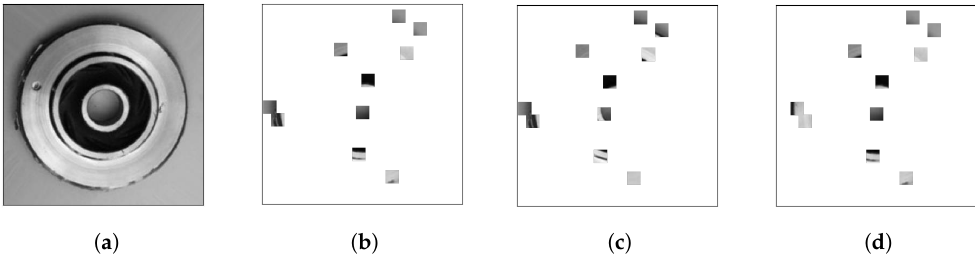
Figure 9. The moving process of agents. ( a ) original image; ( b ) step = 1; ( c ) step = 2; ( d ) step = 3.